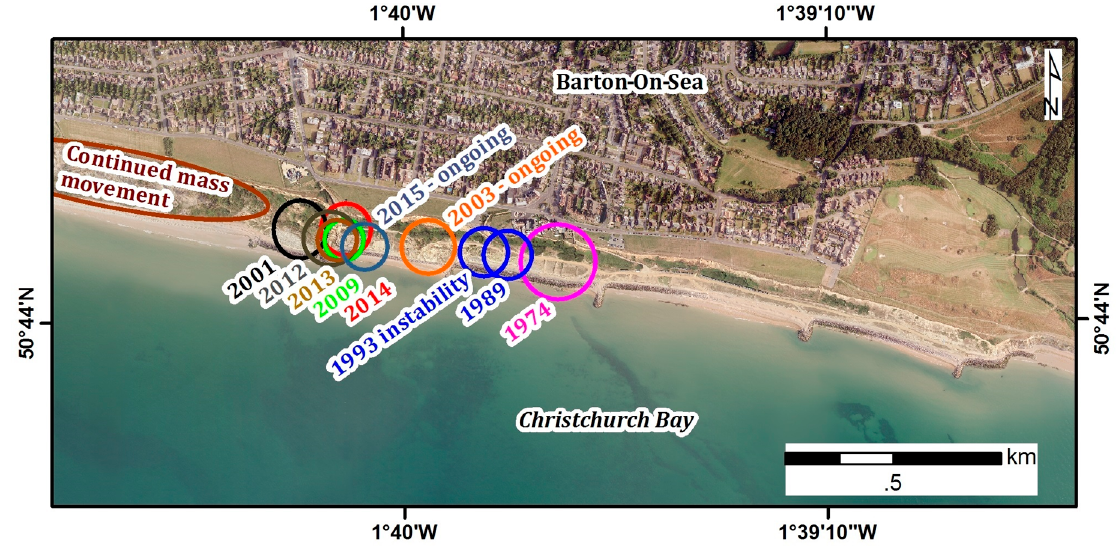
Figure 8. Landslide events and active areas at Barton-on-Sea. Source: Adapted from New Forest District Council [49].